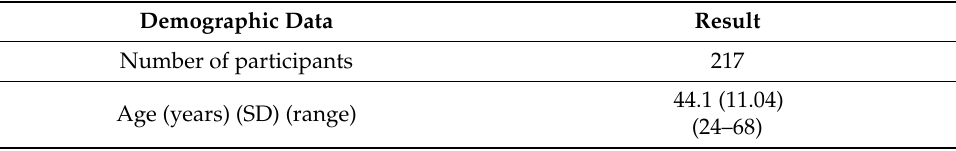
Figure 1. Recruitment scheme of the participating midwives in private practices. Table 2. Demographic data of the participants.